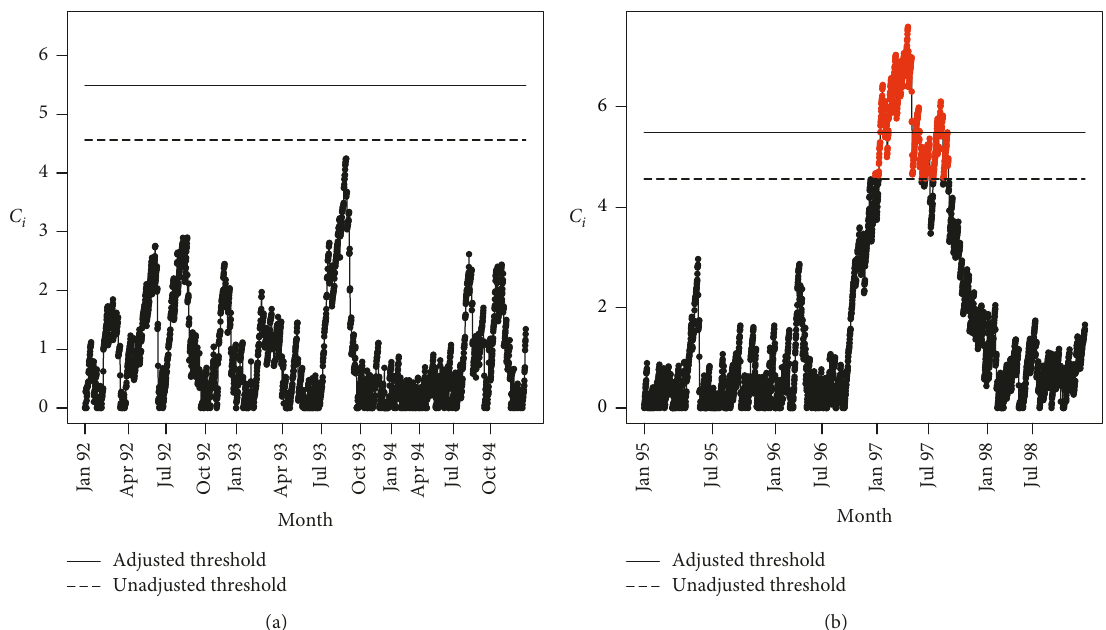
Figure 9: RA-CUSUM chart for Phase-I and Phase-II assuming first three years as the Phase-I for 30 days mortality of cardiac surgery patients. (a) Phase-I chart, unadjusted UCL � 4.563 and adjusted UCL � 5.49. (b) Phase-II chart, unadjusted UCL � 4.563 and adjusted UCL �